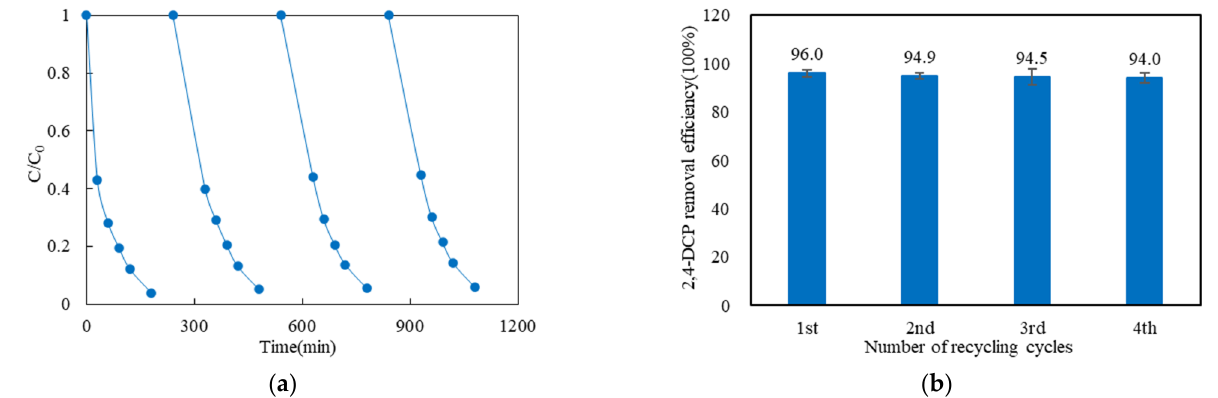
Figure 6. Reuse of the catalyst ( a ) Degradation of 2,4-DCP; ( b ) Removal efficiency of 2,4-DCP.